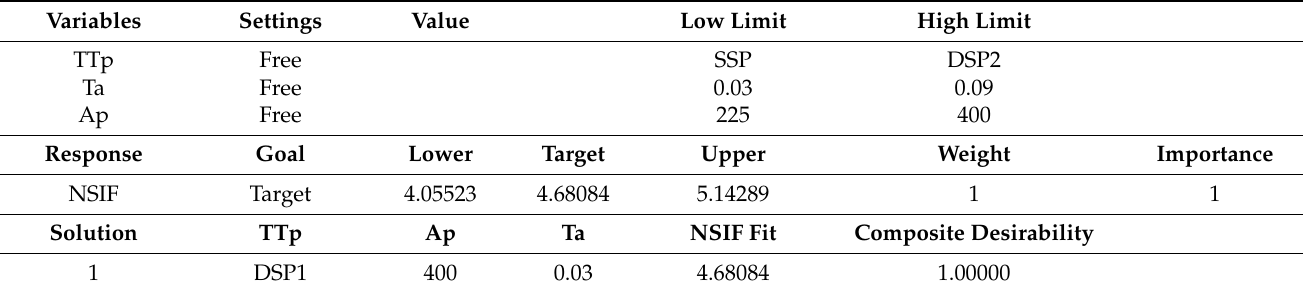
Table 7. Response Optimization: NSIF